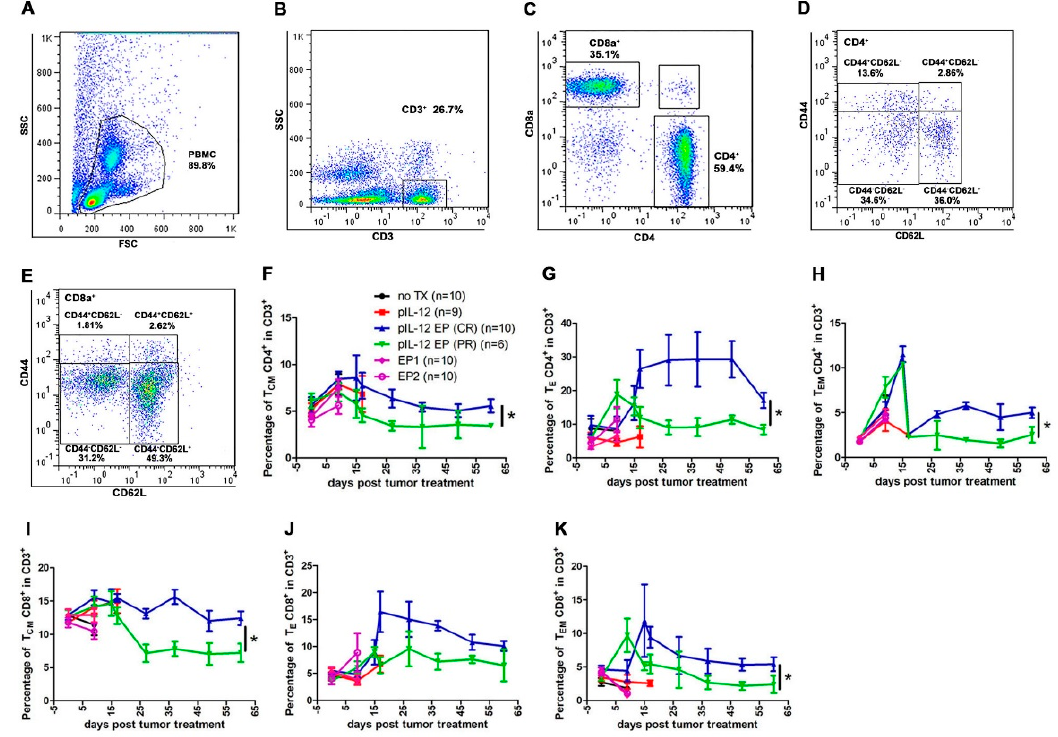
Figure 5. Immunomodulatory effects of pIL-12 GET in B16F10 melanoma model. pIL-12 GET induced an immune response and enhanced percentage of effector CD4 + , CD8 + cells and memory CD4 + , CD8 + cells percentage at different time points. Blood was collected at pre-treatment, and at 9, 17, 27, 37, 49 and 60 days post treatment. Fresh whole blood was used for staining and flow cytometry at each time point. After staining with antibodies, immune cell subsets were detected with flow cytometry. ( A – E ) Flow cytometry gating strategy used for defining immune cell subsets. ( F – H ) Kinetics of the changes of immune cell subsets in CD4 + cells. ( I – K ) Kinetics of the changes of immune cells subsets in CD8 + cells. The data presented are representative of two independent experiments. Each value represents the mean +/ − SEM of the group (animals in each group, n = 6–10). One-way ANOVA, p * < 0.05.